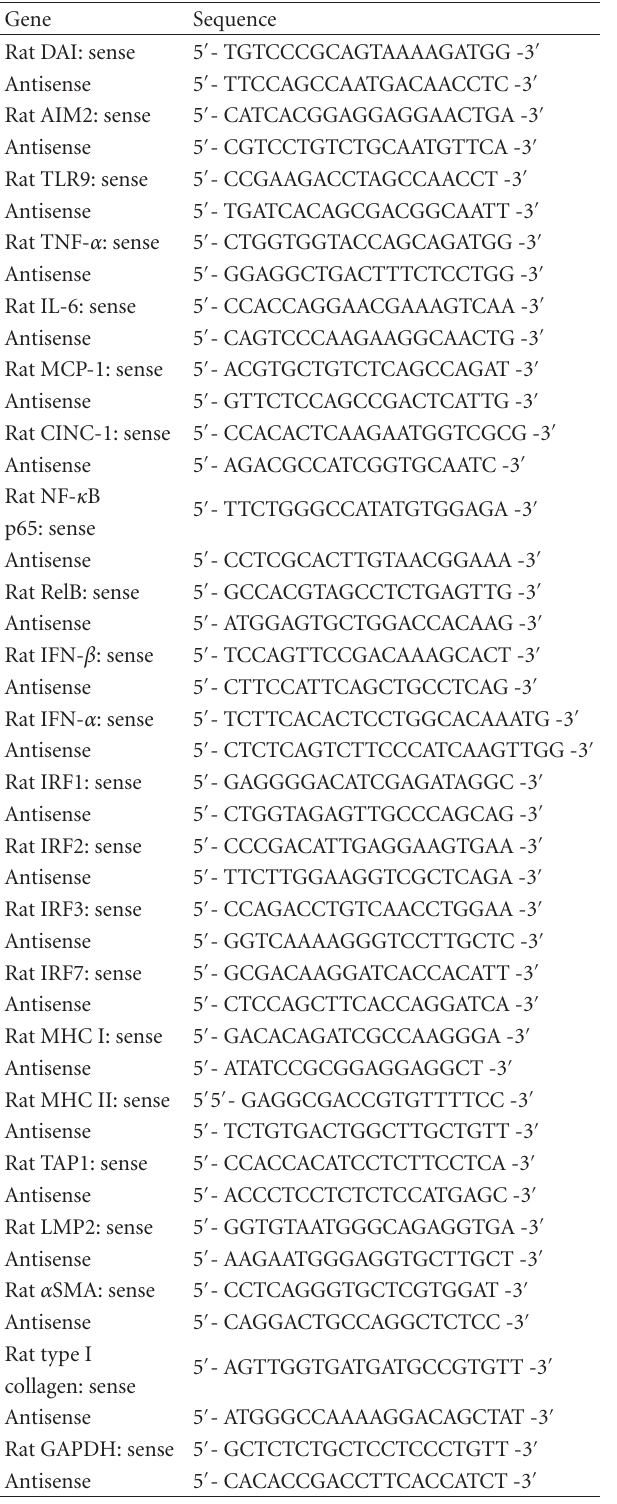
Table 1: Sequences of primers used in this